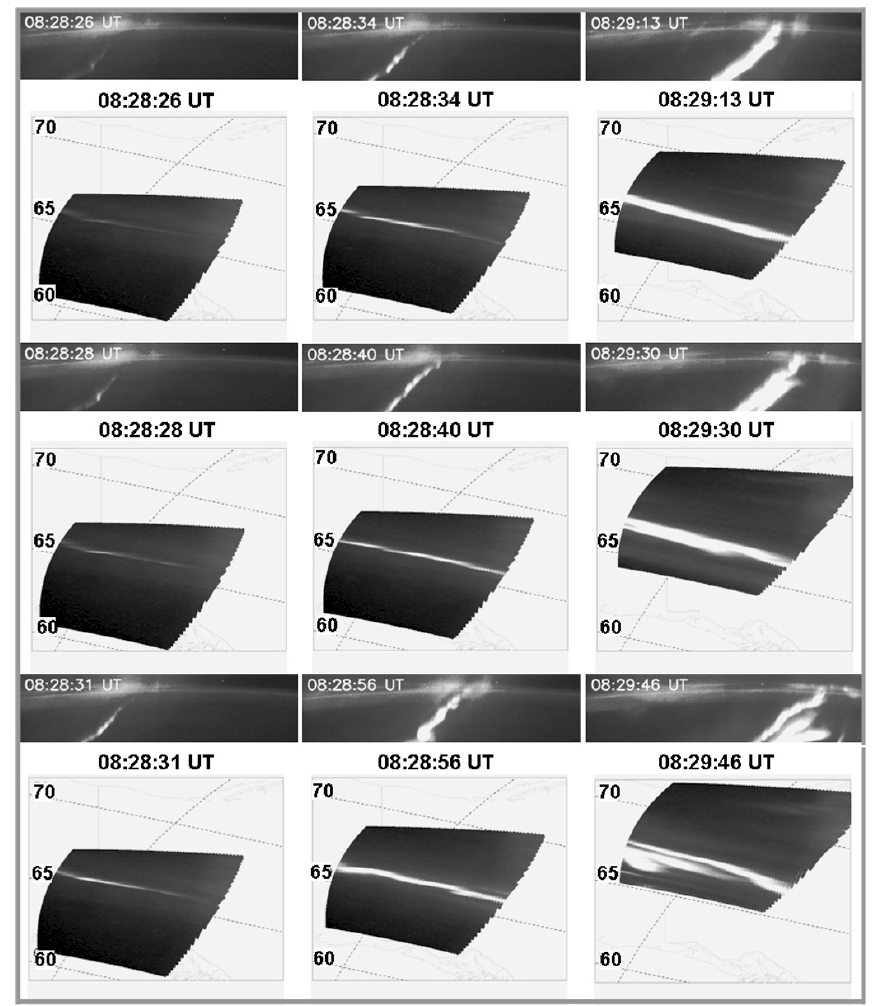
Fig. 5. Auroral arc evolution and breakup of the 21 December 2006 substorm observed by the ISUAL Imager on board the FORMOSAT-2